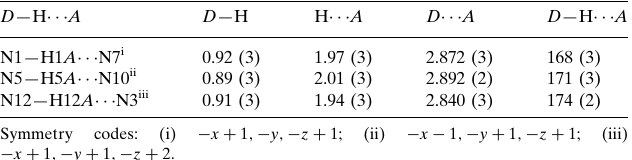
Hydrogen-bond geometry (A˚ , (cid:1) ). D —H (cid:2)(cid:2)(cid:2)